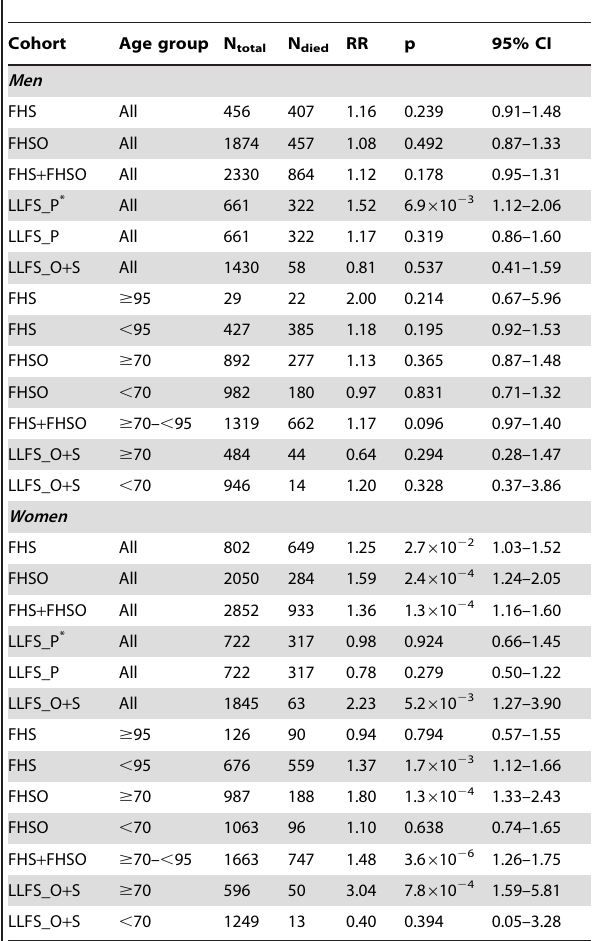
Table 2. Relative risks of death for the ApoE4 allele carriers compared to the non-carriers in the selected age groups of the genotyped participants of the FHS original, FHSO, and LLFS